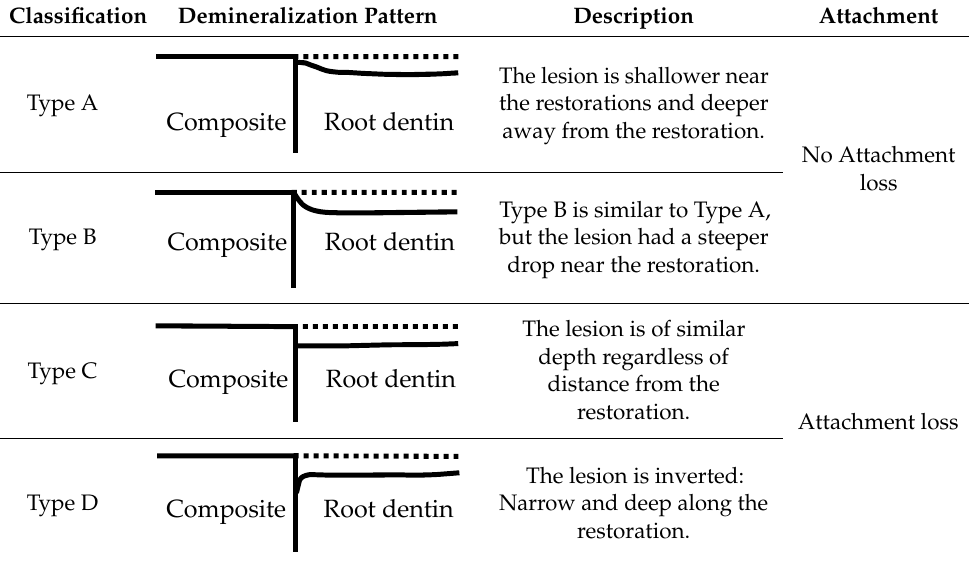
away from the restoration.